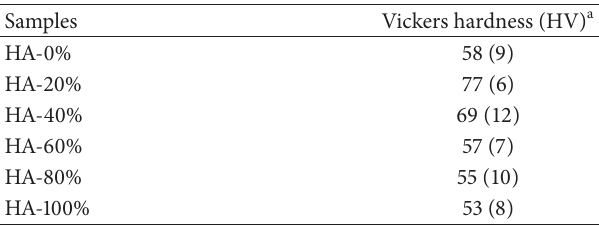
Table 2: Vickers hardness of different mass fraction of hydroxyap- atite based